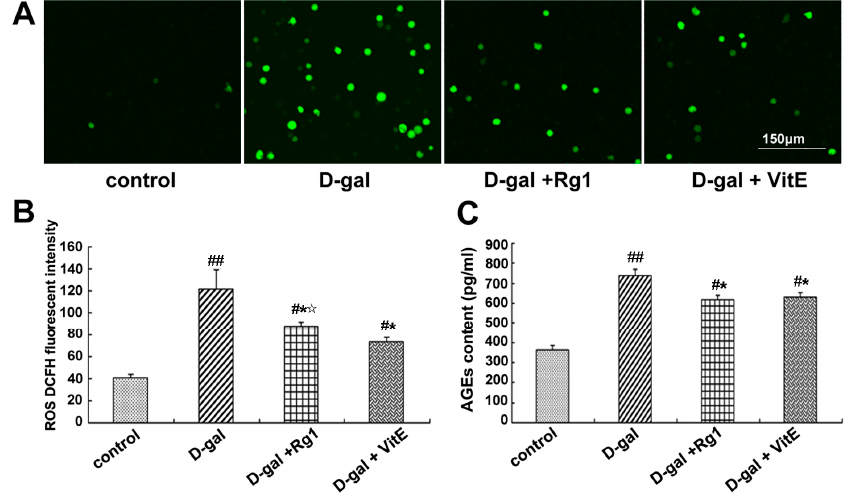
Figure 2. Effects of ginsenoside Rg1 on ROS level and AGEs content in the mouse model of D -gal-induced aging. ( A ) The DCFH (dichlorodi hydrofluorescein diacetate) fluorescence level of